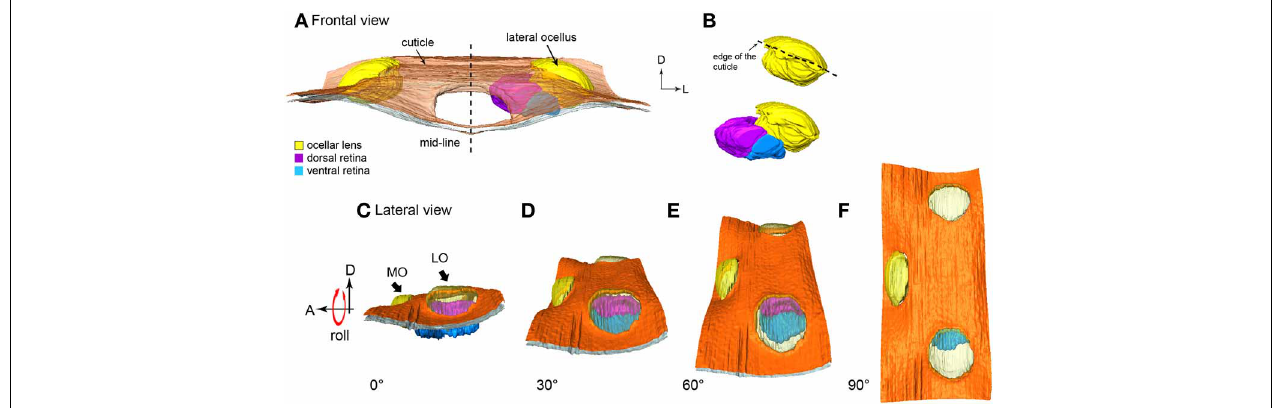
FIGURE 3 | 3-D reconstruction of the honeybee lateral ocellus. (A,B) frontal views of the lateral ocellar lens and retinas. (A) the inner surface of the lens (l, shown in yellow) of the lateral ocellus is asymmetrical, the dorsal (dr, shown in purple), and ventral (vr, blue) retinas follow the inner surface of the lens and are pointing toward the midline of the brain. (C–F) Simulation of the rolling movement of the model. The ocelli are viewed from the side of the